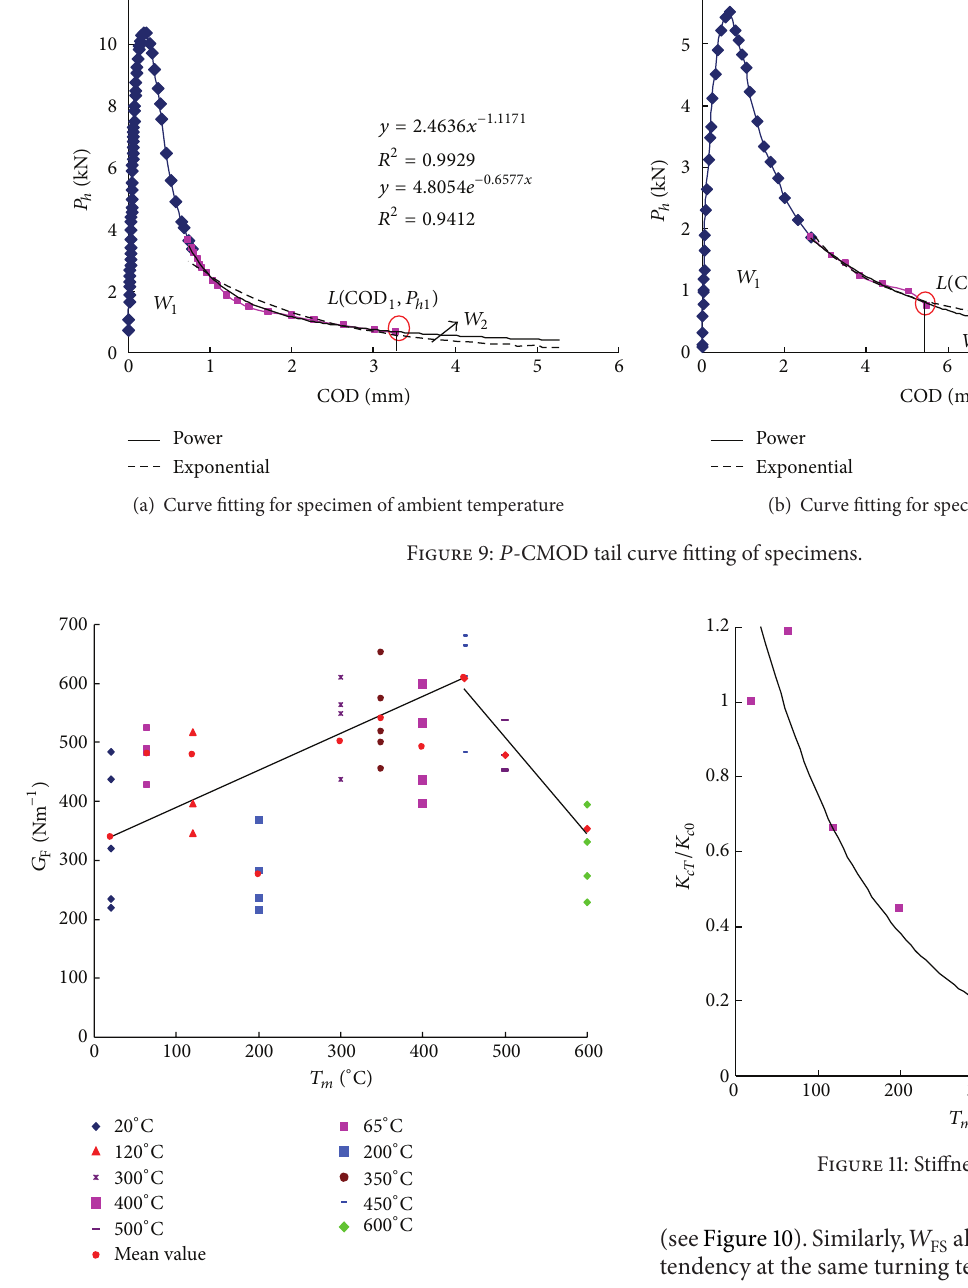
Figure 10: Residual fracture energy with 𝑇 𝑚 .